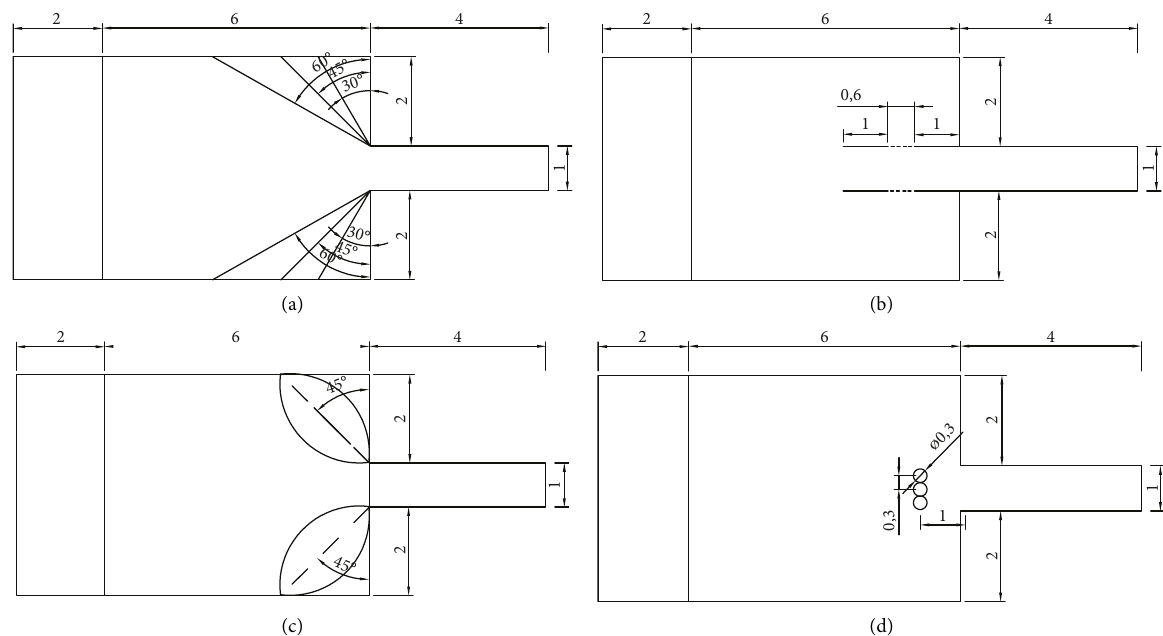
Figure 3: Setting of optimization methods [30, 32]. (a). A design with funnel-shaped (b). A design with extended guardrails (c). A design with concave or convex (d). a design with column obstacles.